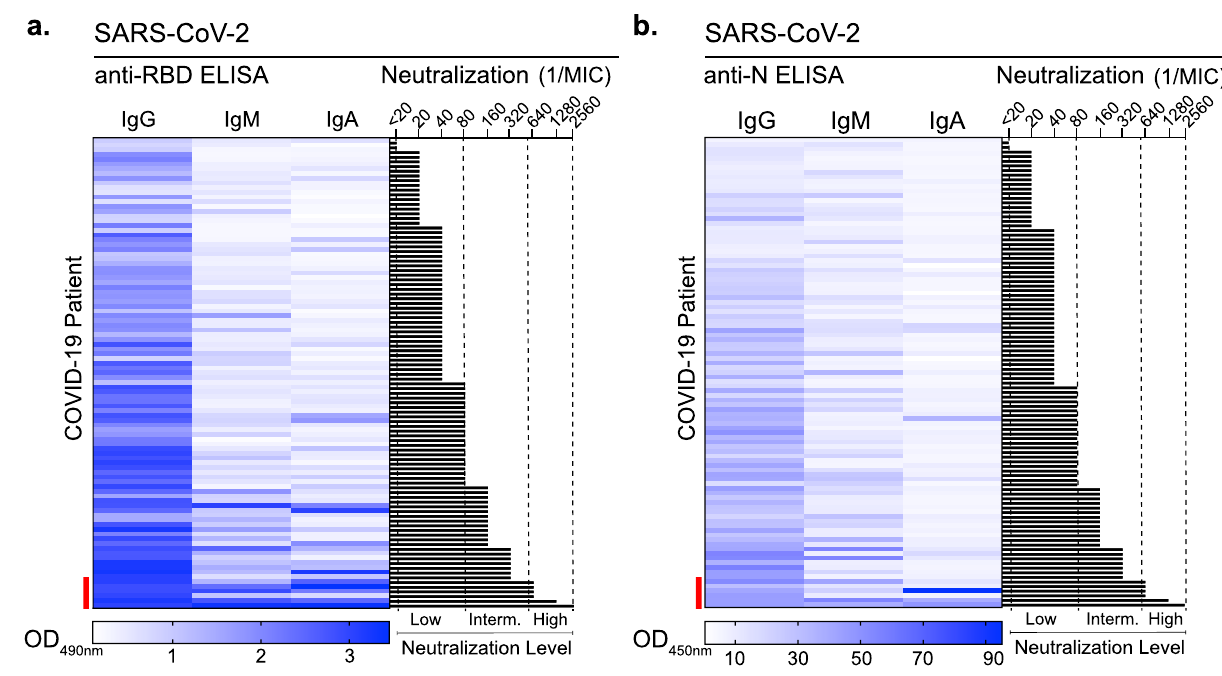
Figure 4. Identification of serological signatures for neutralization. Heatmap of anti-RBD ( a ) and anti-N ( b ) antibody isotype ELISA titers and corresponding authentic SARS-CoV-2 neutralization. Serological data from the 101 COVID-19 patients was ranked from low to high neutralization. Sera of convalescent patients was defined as low (dil 1/10 to 1/80), intermediate (dil 1/81 to 1/639) and high (dil > 1/640). Red bar indicates those COVID-19 patients with high neutralizer